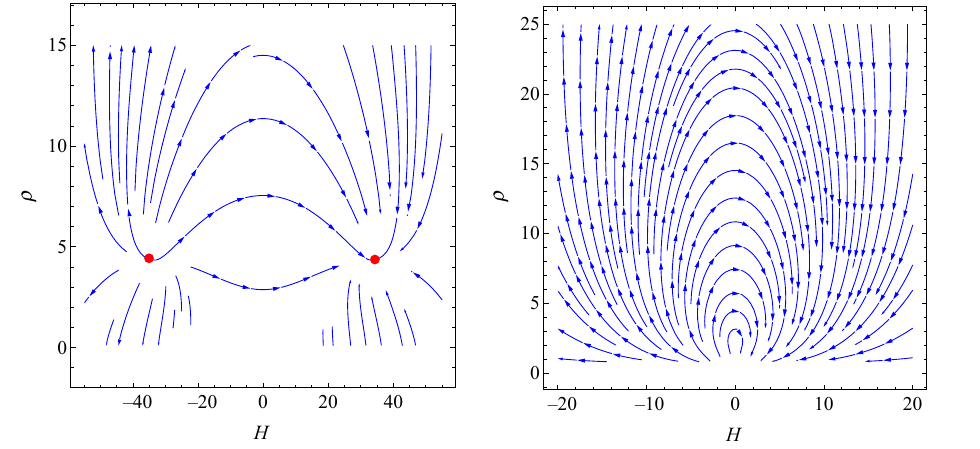
Fig. 2 The vector field portrait in phase space ( H ,ρ) corresponding to Fig. 1. Left panel corresponds to any three curvature modes of Sny- der deformed-FRW model with numerical values: μ 0 = − 1, ρ ∗ =